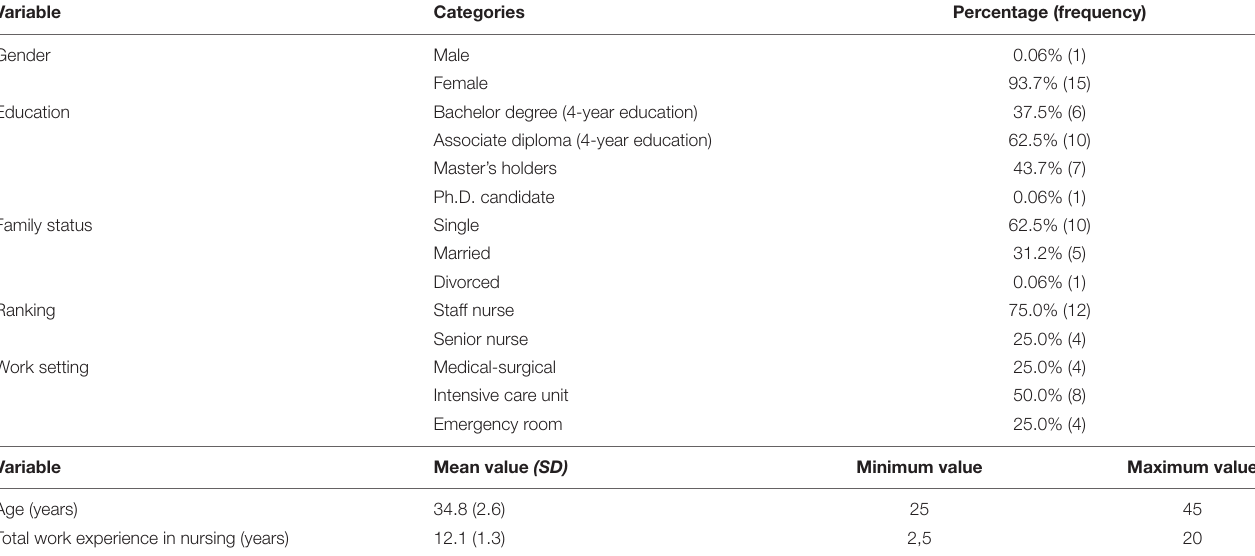
TABLE 1 | Demographic, educational and work-related characteristics of the participants ( n =